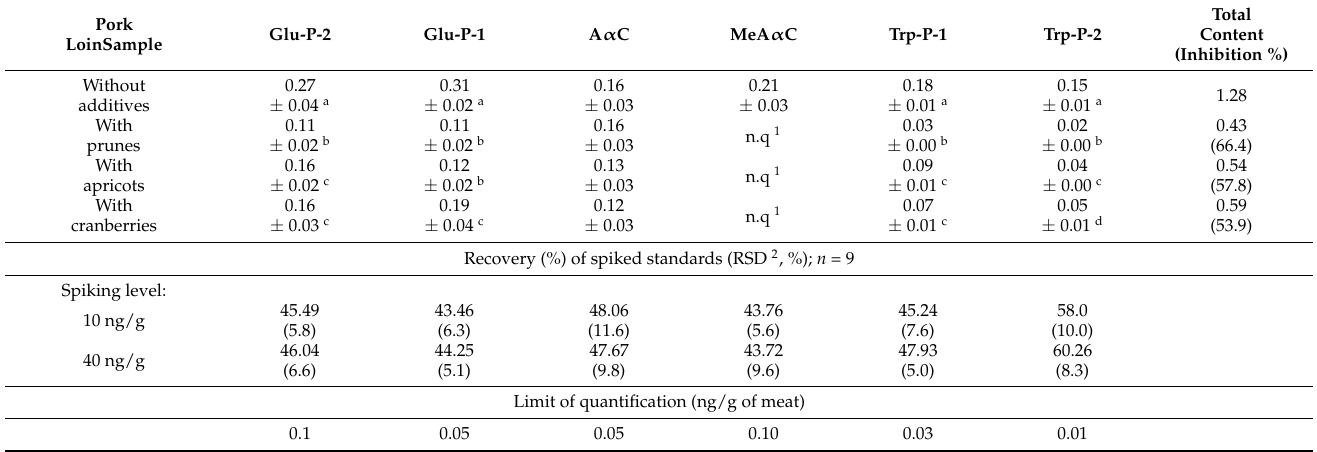
Table 3. Concentrations (recovery corrected values) of δ -, α - and γ -carbolines in meat cooked with and without additives (ng/g). The results are presented as means ± standard deviations (SD), corresponding to duplicate HPLC analyses of fractions obtained by triplicate extractions ( n =